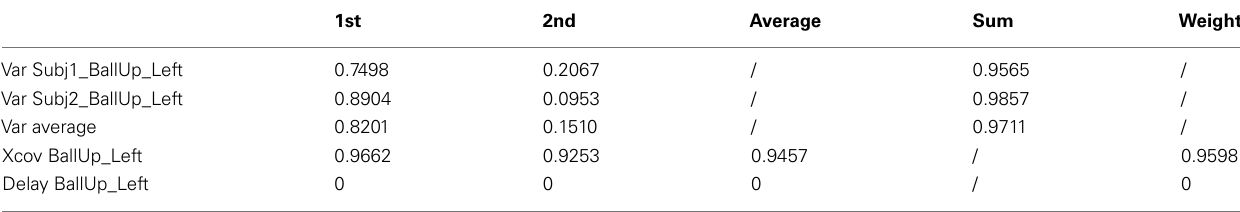
TableA5 | Reaching a target with the left hand (2 subjects).